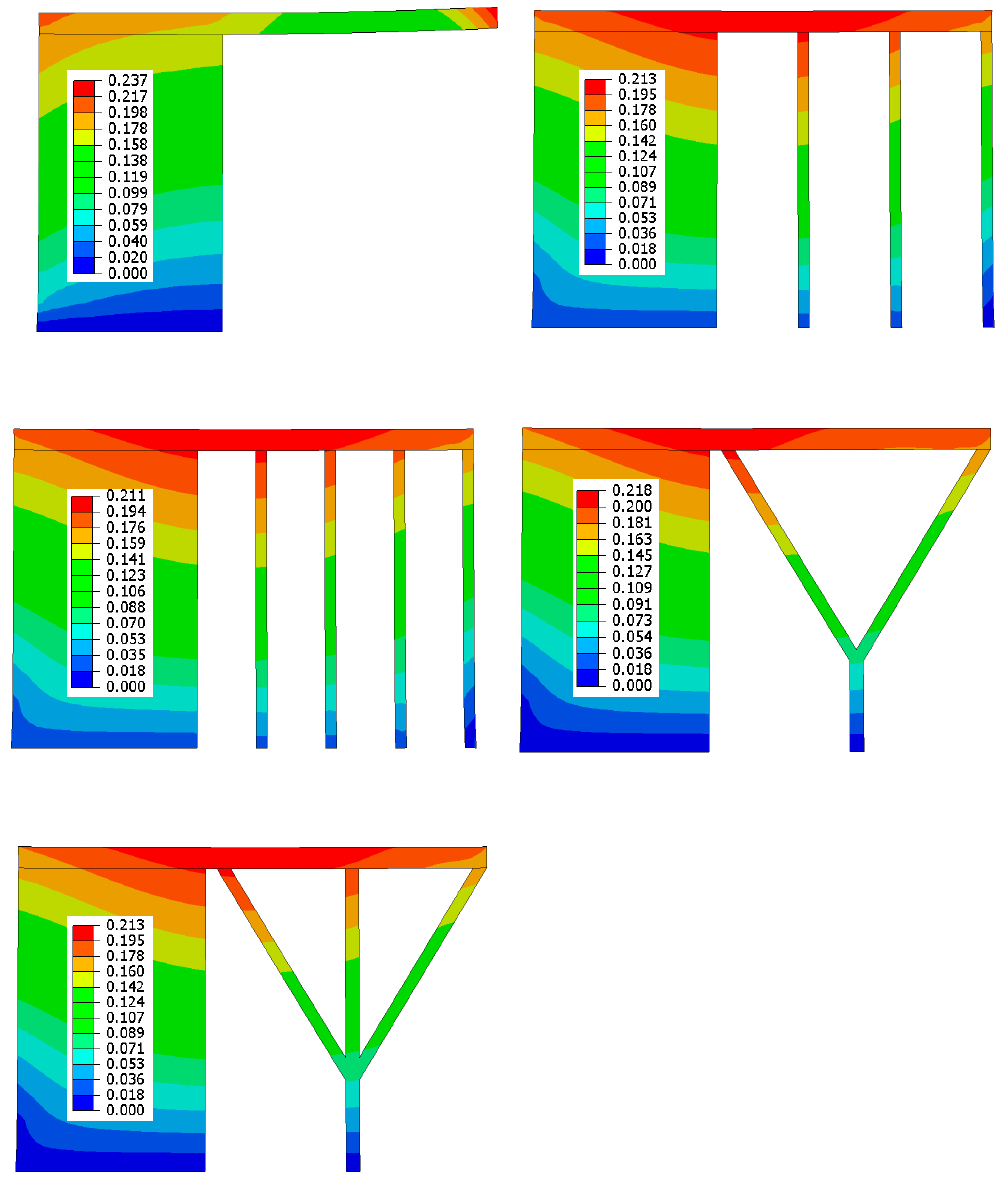
Figure 10. Total deformation (mm) in FE models with final build-up.